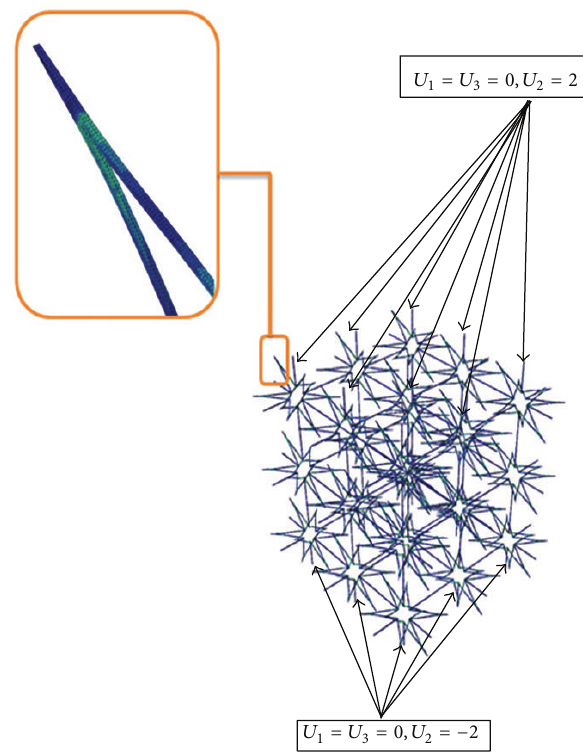
Figure 3: Von Misses stress of Model number 1 in the case of uniaxial imposed displacement along 𝑦